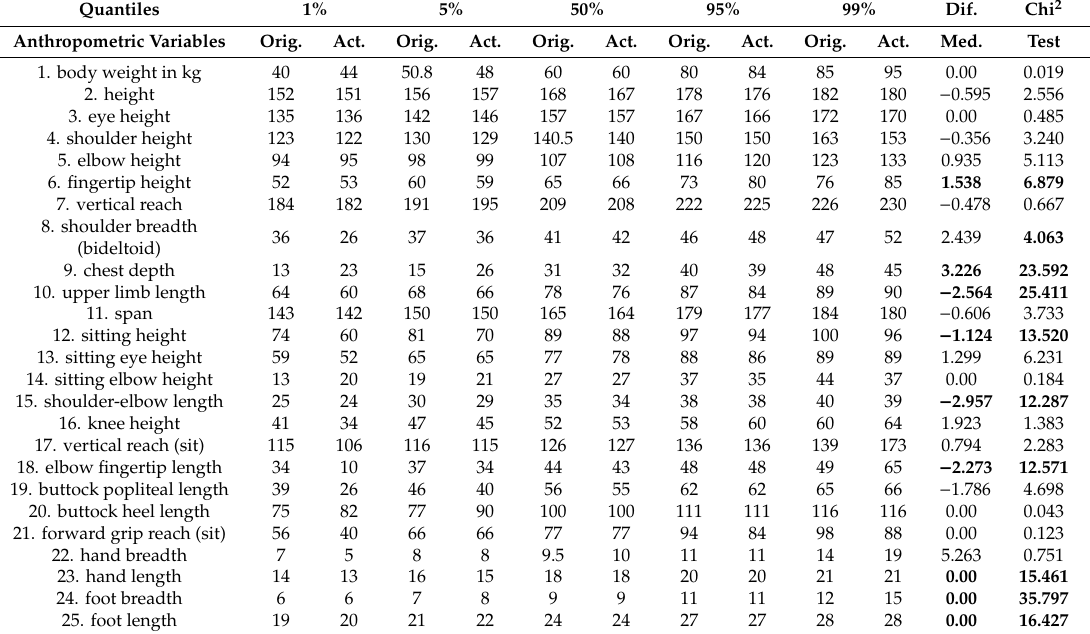
Table 6. Comparison of the original (the year 2004) and actual (the year 2018) quantiles of selected anthropometric variables of the female population in the Czech Republic.